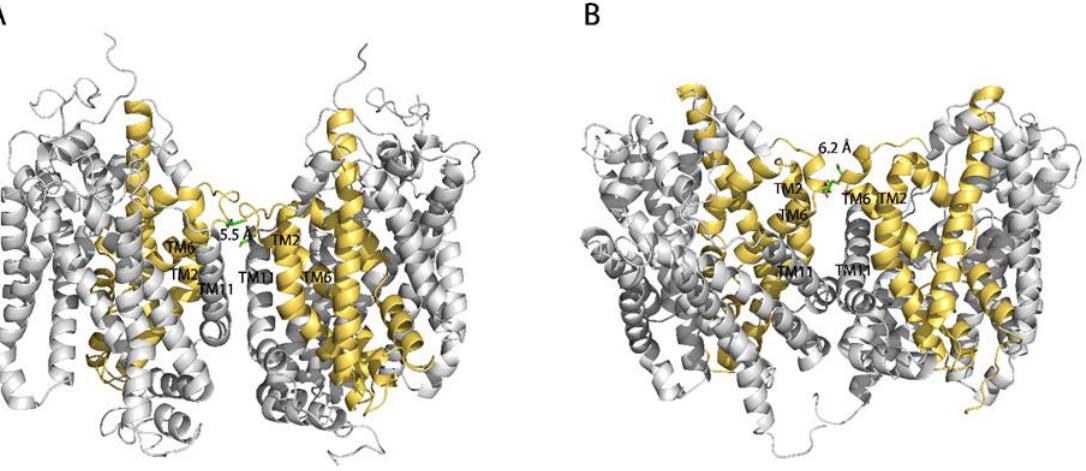
Figure 8. Dimer docking of GlyT1 L288C with both protomers in an inward open ( A ) or an outward open conformation ( B ). Dimer docking was performed based on the crystal structure of GlyT1 in an inward open conformation (PDB accession code, 6ZPL) [26] and the GlyT1b model in an outward open conformation. The distance between two dimeric cysteines replacing Leu288 in the inward-open dimer and outward-open dimer are 5.5 and 6.2 Å, respectively. The bundle domains (TMs 1, 2, 6, and 7) and other part of the protein are colored in golden and gray, respectively.